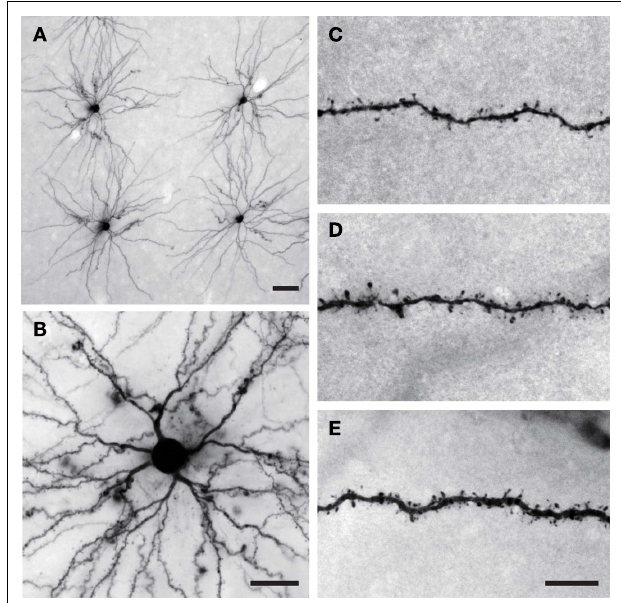
FIGURE 2 | (A) Low and (B) intermediate power photomicrographs of layer III pyramidal cells sampled from the anterior ventral portion of cytoarchitectonic areaTE that were injected with LuciferYellow and processed with a diamino-benzidine reaction product. (C–E) High power photomicrographs of the basal dendrites of layer III pyramidal cells sampled fromTEav illustrating differences in spine density at different ages. Scale bar = 50 μ m in (A) , 25 μ m in (B) , and 10 μ m in (C–E) .